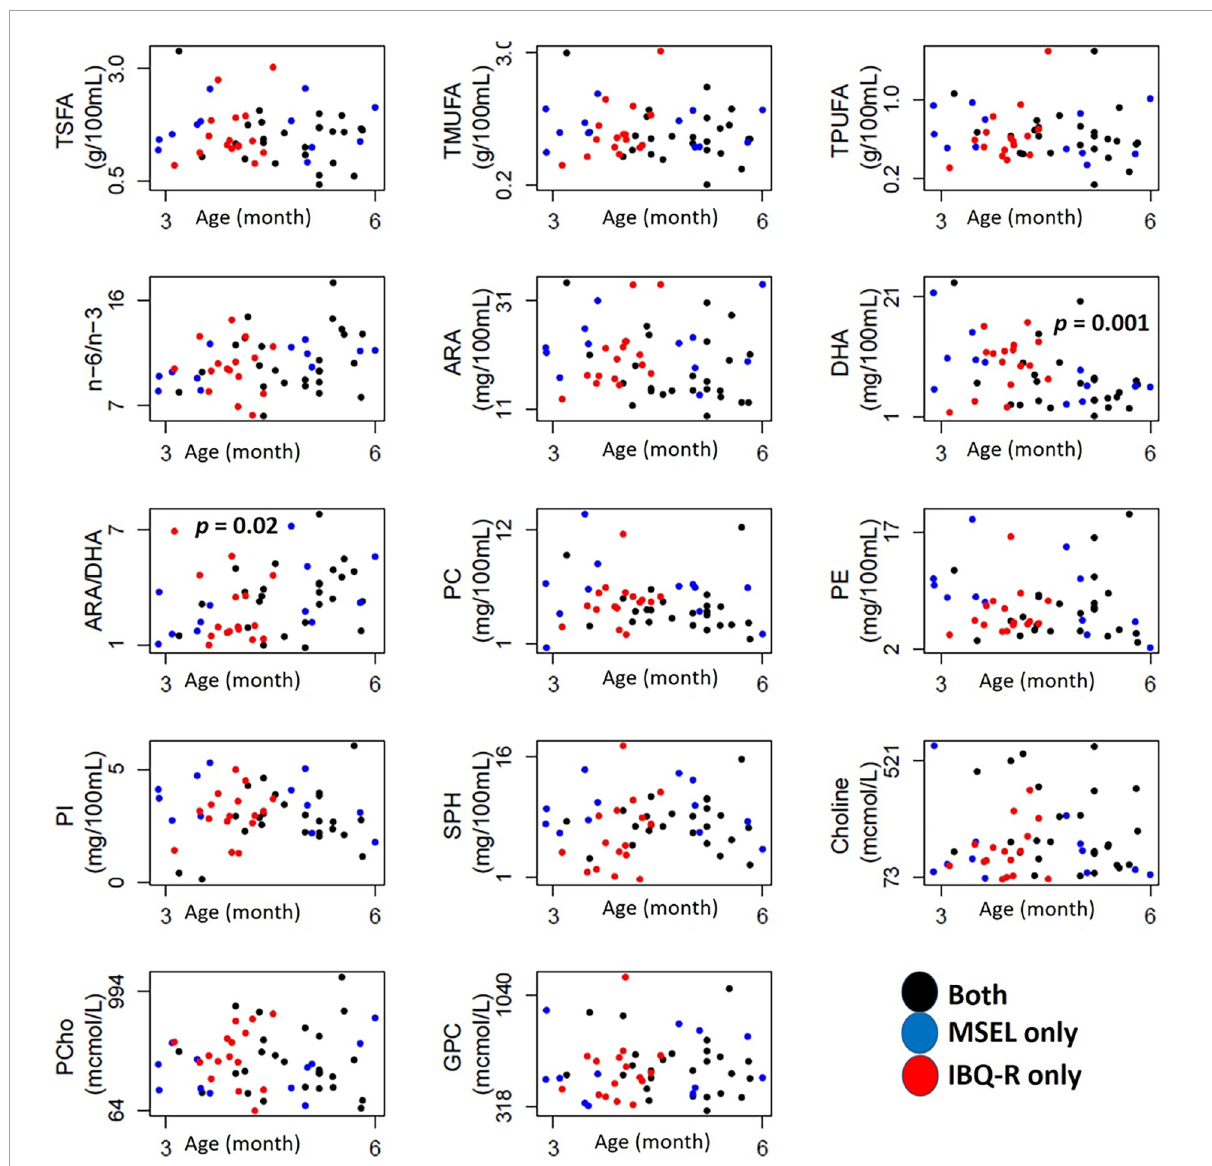
FIGURE2 Scatterplots of the 14 nutrients with age in months (x-axis) for subjects assessed with MSEL (blue circles), IBQ-R (red circles), and both (black circles). TMUFA, total monounsaturated fatty acids; TPUFA, polyunsaturated fatty acid; TSFA, saturated fatty acid; ARA, arachidonic acid; DHA, docosahexaenoic acid; ARA/DHA, the ARA-to-DHA ratio; n-6/n-3, omega-6/omega-3 polyunsaturated fatty acids ratio; PC, phospholipids; PE, phosphatidylethanolamine; PI, phosphatidylinositol; SPH, sphingomyelin; Choline, free choline; PCho, phosphocholine; GPC, glycerophosphocholine; SUR, surgency; NEG, negative affectivity; REG, regulation; mcmol,